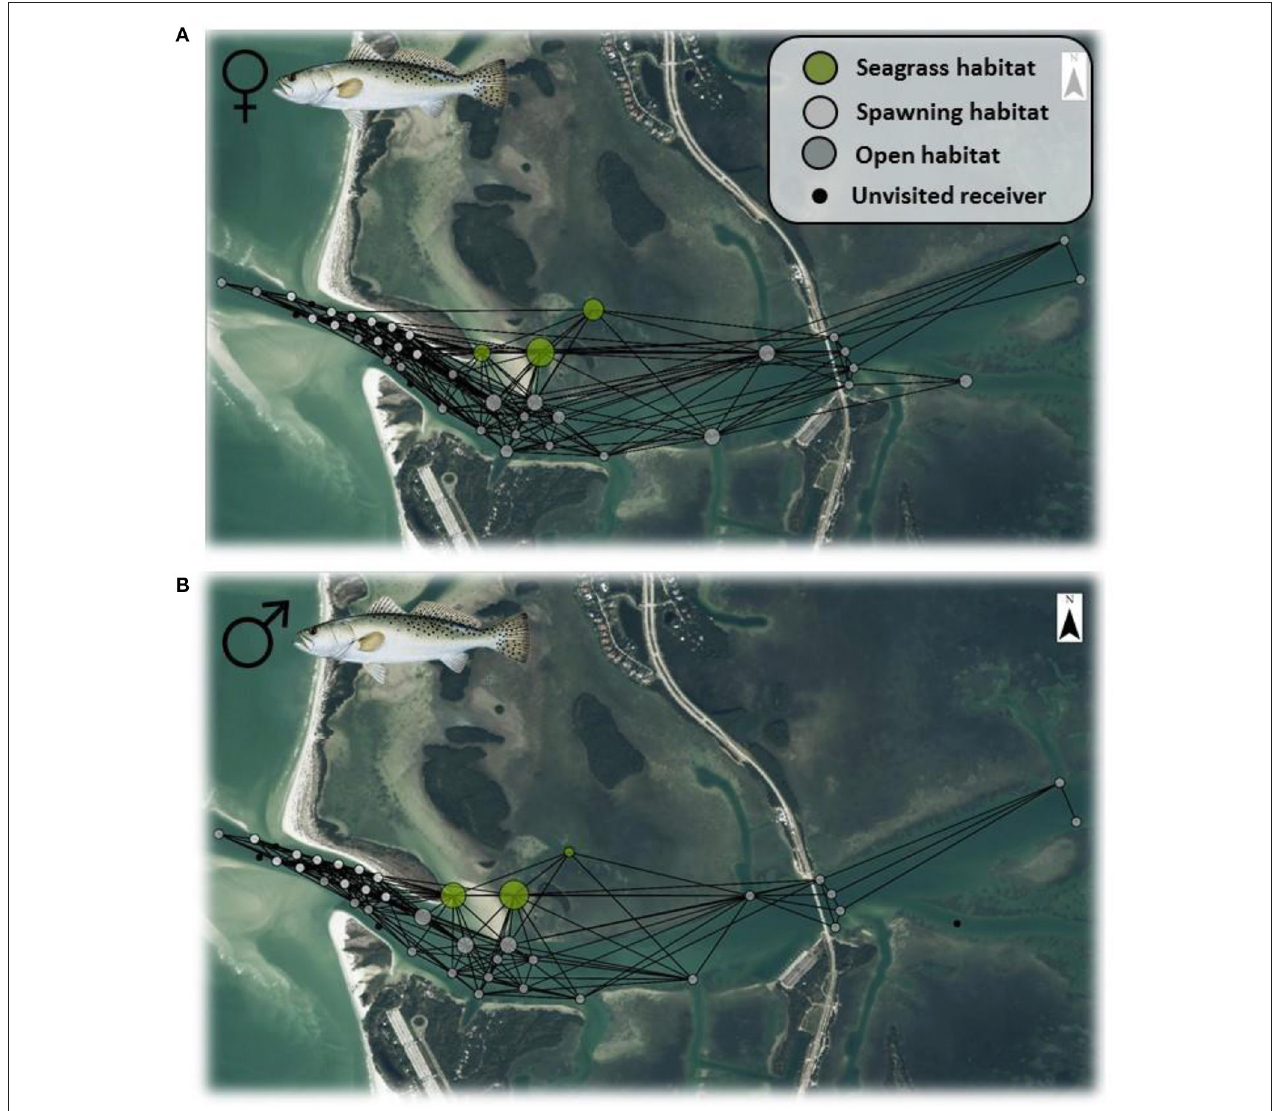
FIGURE 3 | Weighted network for female (A) and male (B) Seatrout in Tampa Bay according to the spatial layout of acoustic receivers. Node coloration corresponds to different habitats, while node size corresponds to the degree centrality, a measure of node connectedness. Green shading represent the seagrass habitat, and light gray shading represent the spawning habitat, dark gray shading shows open habitats, and black dots show unused